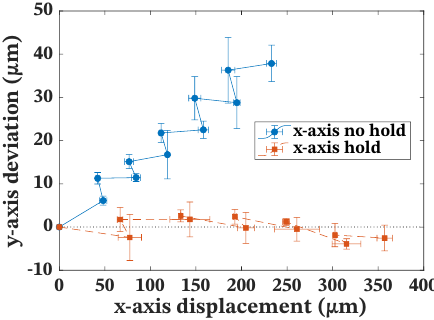
Figure 13. 1D displacements along the x